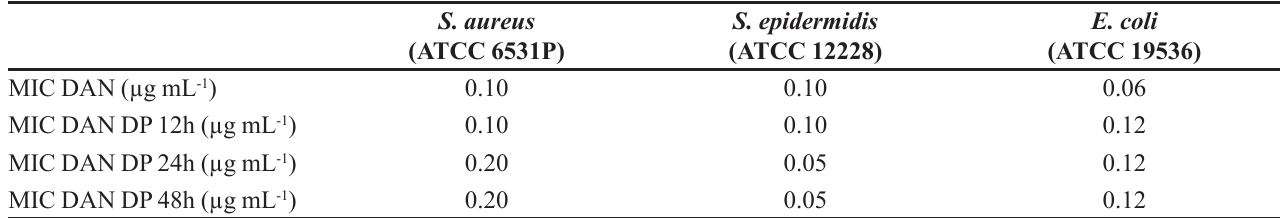
TABLE II - Minimal inhibitory concentration (MIC) to danofloxacin in absence or in the presence of degradation products (DAN